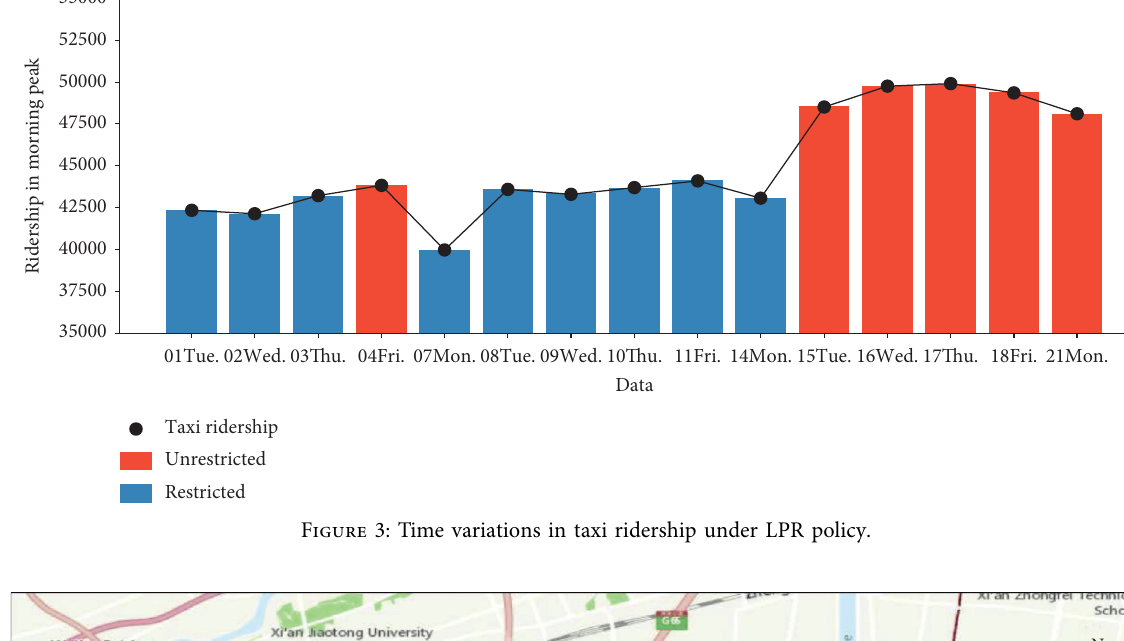
Figure 3: Time variations in taxi ridership under LPR policy.